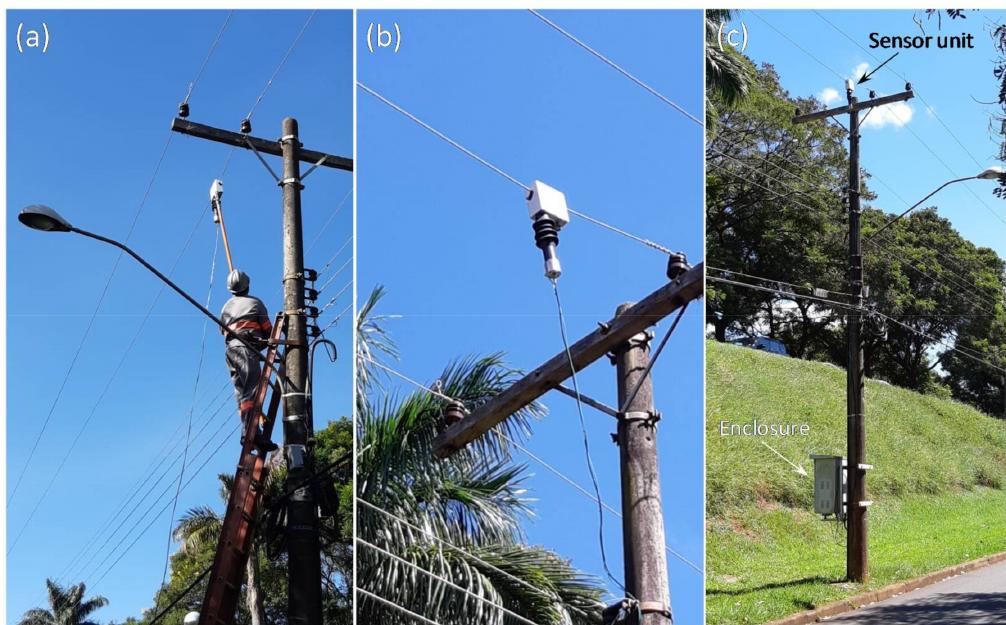
Figure A1. ( a ) Sensor installation in a phase of 11.9 kV distribution network, ( b ) sensor installed, and ( c ) the sensor and processing unit.